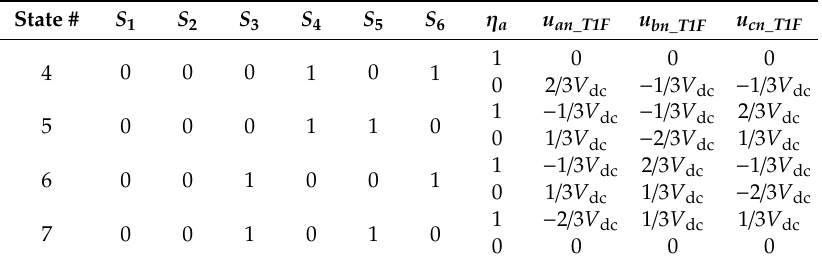
Table 3. The relationship between switching states and phase voltages in the case of a T 1 OC fault acting on the inverter